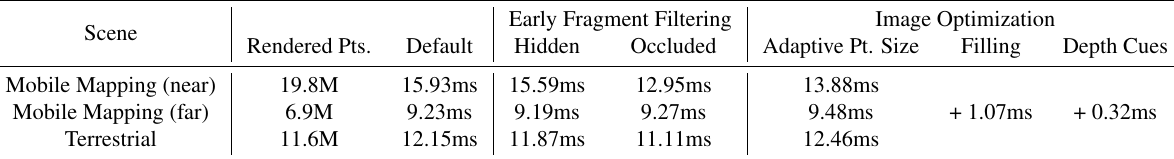
Table 1. Average rendering performance in ms/frame. Dynamic memory budget was disabled to ensure comparability of measured values. Filtering of hidden and occluded fragments was enabled for all image optimization